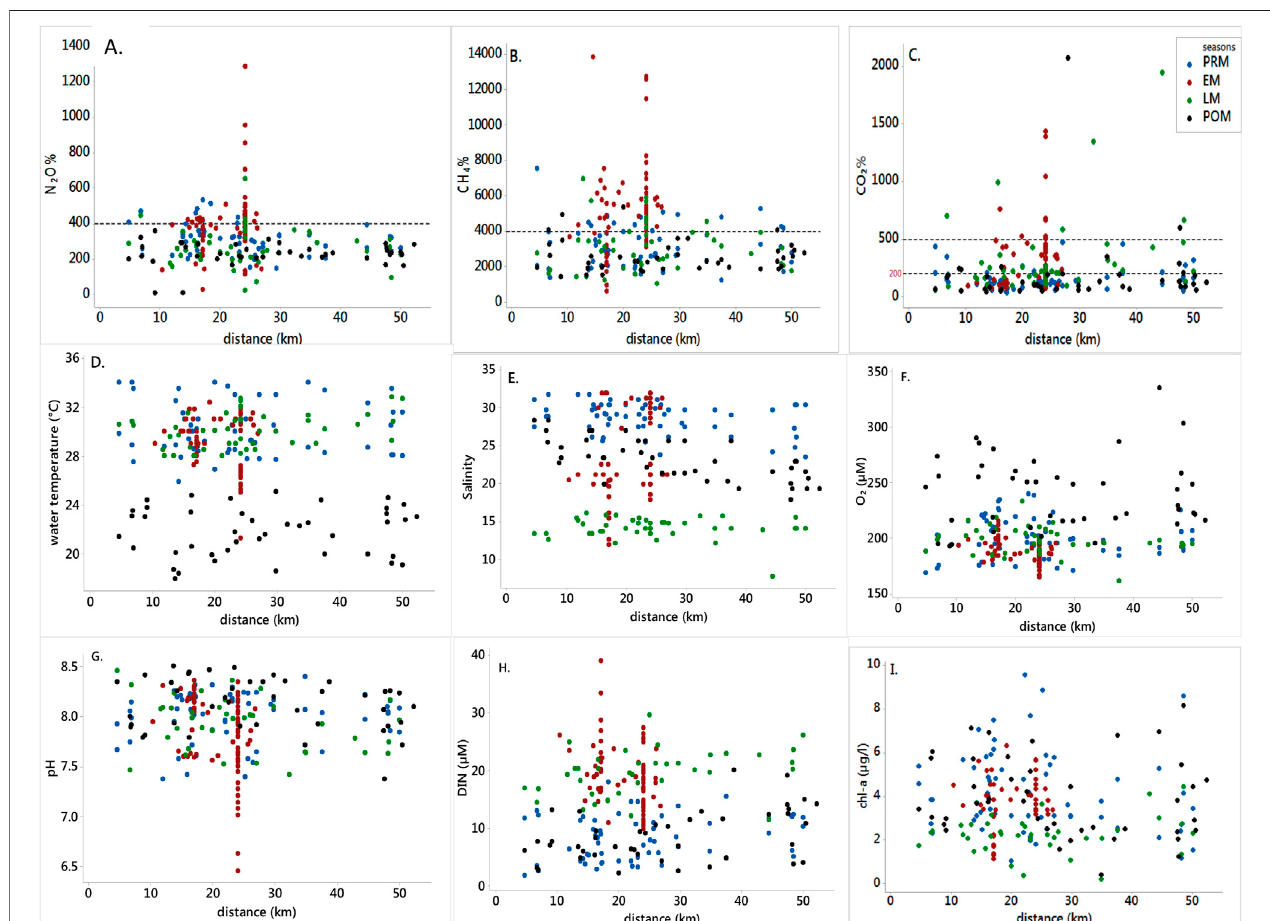
FIGURE 2 | Scatter plots showing CO 2 , CH 4 , and N 2 O saturation and estuarine physicochemical parameters measured from the head to the mouth of the Indian SundarbanestuarybetweenApril2016andJanuary2020.The x -axisrepresentsthedistancefromthemouthoftheestuary.Bluedotsrepresentobservationsfrompre- monsoon (PRM), red dots represent early monsoon (EM), green for late monsoon (LM), and black dots are for post-monsoon (POM).